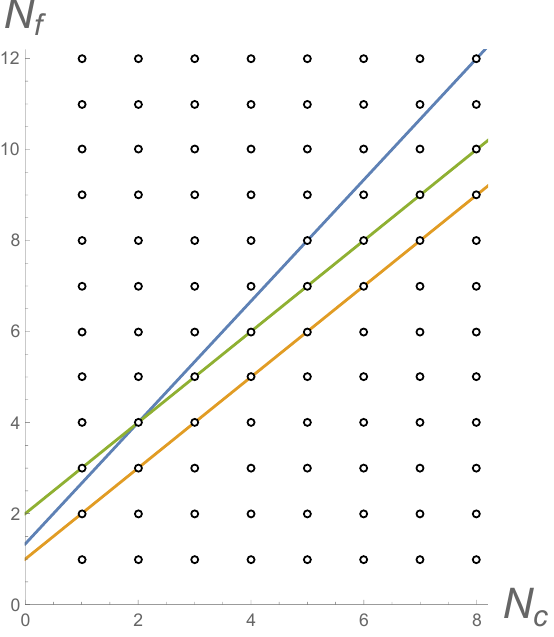
Figure 2 . Dynamics of T M in various regions of the parameter space N c ; N f . Blue line N f = 4 ( N c + 1), green line N f = N c + 2, orange line N f = N c + 3